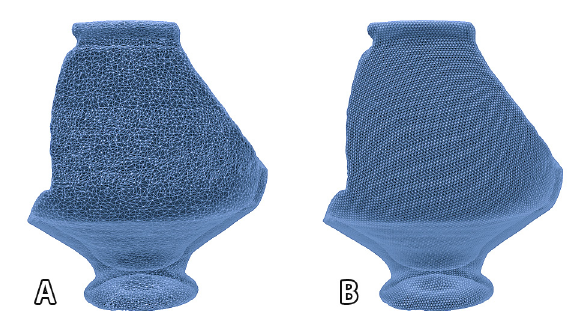
Figure 3. The same 3D surface model, decimated by PhotoScan (A) and retopologised by Instant Meshes (B) to 40k